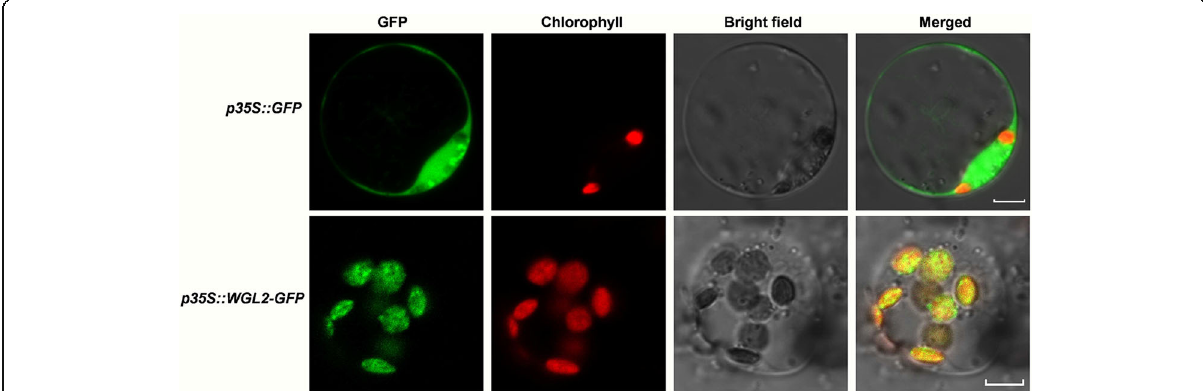
Fig. 5 Subcellular localization of the WGL2-GFP protein in rice protoplasts. GFP signals show that the WGL2-GFP fusion protein produced from the p35S::WGL2-GFP construct localized to the chloroplast and the control GFP localized to the cytoplasm and nucleus. Green fluorescence shows GFP, red fluorescence shows chloroplast autofluorescence, and yellow fluorescence shows the merged fluorescence. (bar = 5 μ